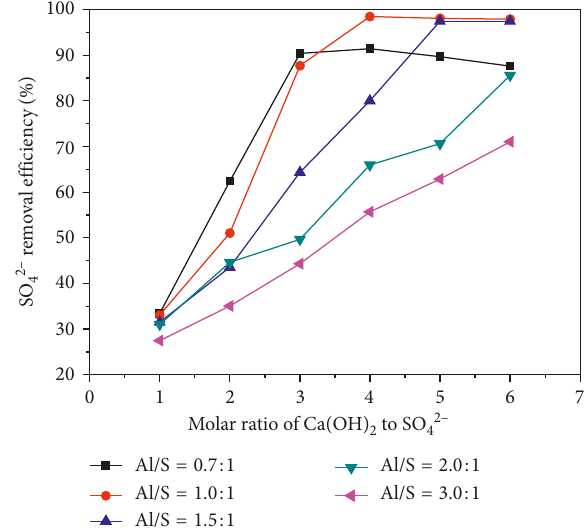
Figure 1: The effect of NaAlO v 200r/min, t (cid:27)